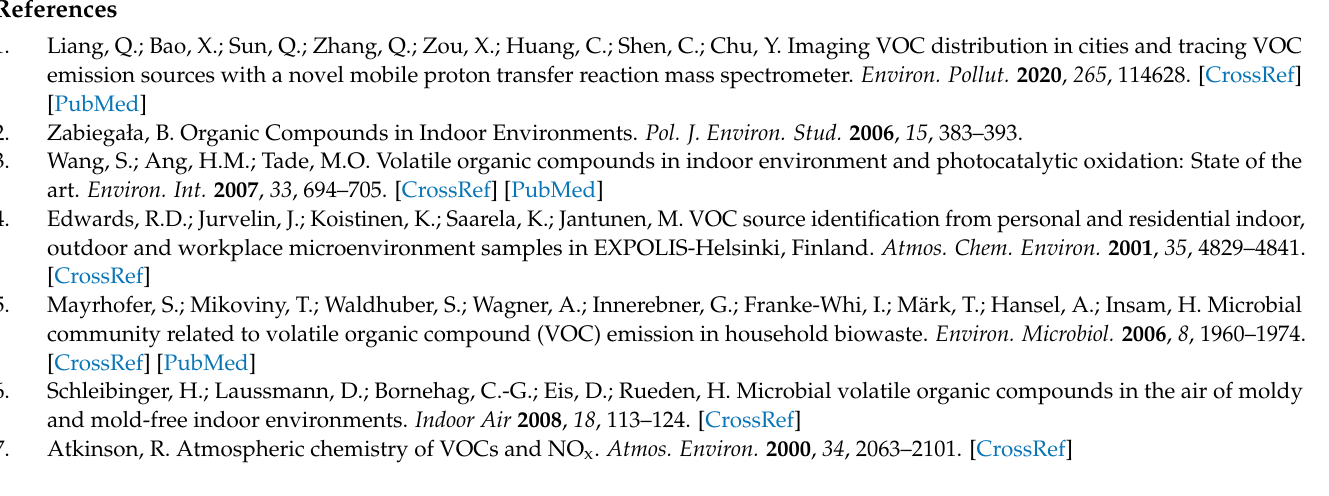
Figure S2: Ethanol conversion, ozone conversion, products selectivity and carbon balance as a function of time on stream in dry (left) and humid (right) conditions (catalyst = 20 mg, total flow rate = 500 mL min − 1 , [EtOH] = 10 ppm, [O 3 ] = 70 ppm, T = 60 ◦ C) for the 10Mn/TiO 2 mM catalyst calcined at 400 ◦ C, Figure S3: Ethanol conversion, ozone conversion, products selectivity and carbon balance as a function of time on stream in dry (left) and humid (right) conditions (catalyst = 20